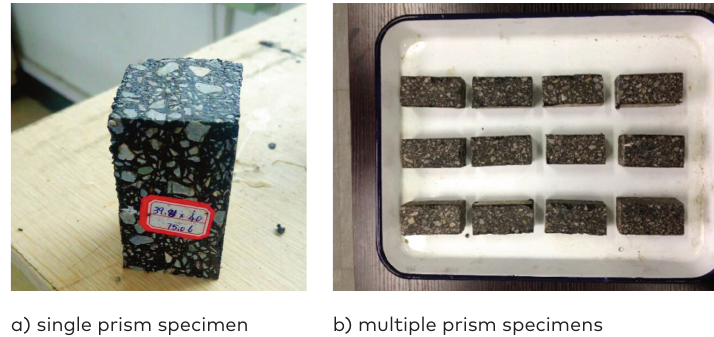
Figure 4. Prismatic specimens of asphalt mixture